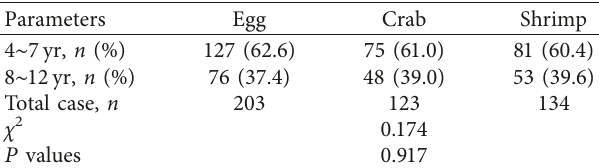
Table 3: IgE in different age groups.